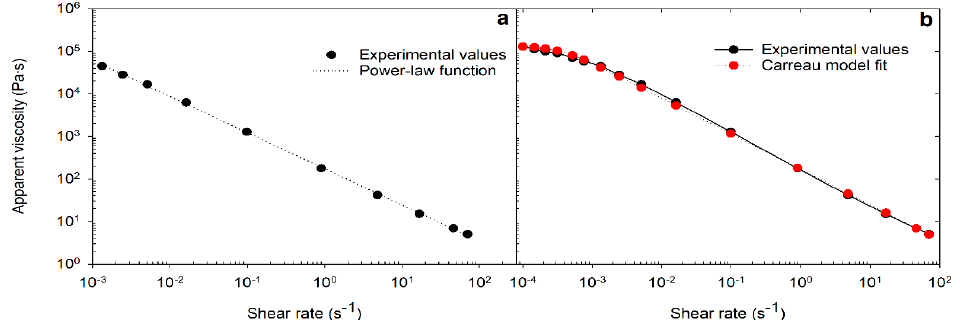
Figure 1. Viscosity flow sweep curves of cream ( a ) and gel ( b ) samples as a function of controlled shear stress. Reference lines from left to right are placed at 1, 10, 80, 100, and 350 Pa in ‘plot a’ and at 10, 100, and 350 Pa in ‘plot b’.